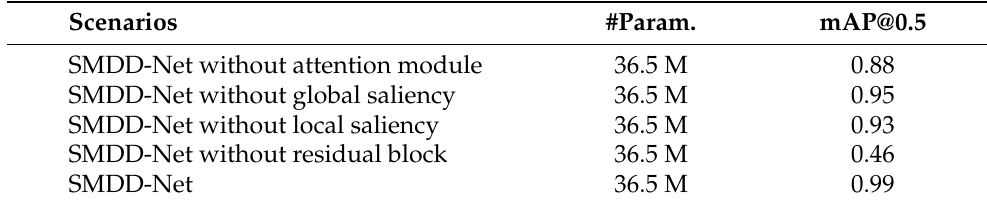
Figure 4. Detection samples from SMDD-Net. Table 2. Ablation test results for